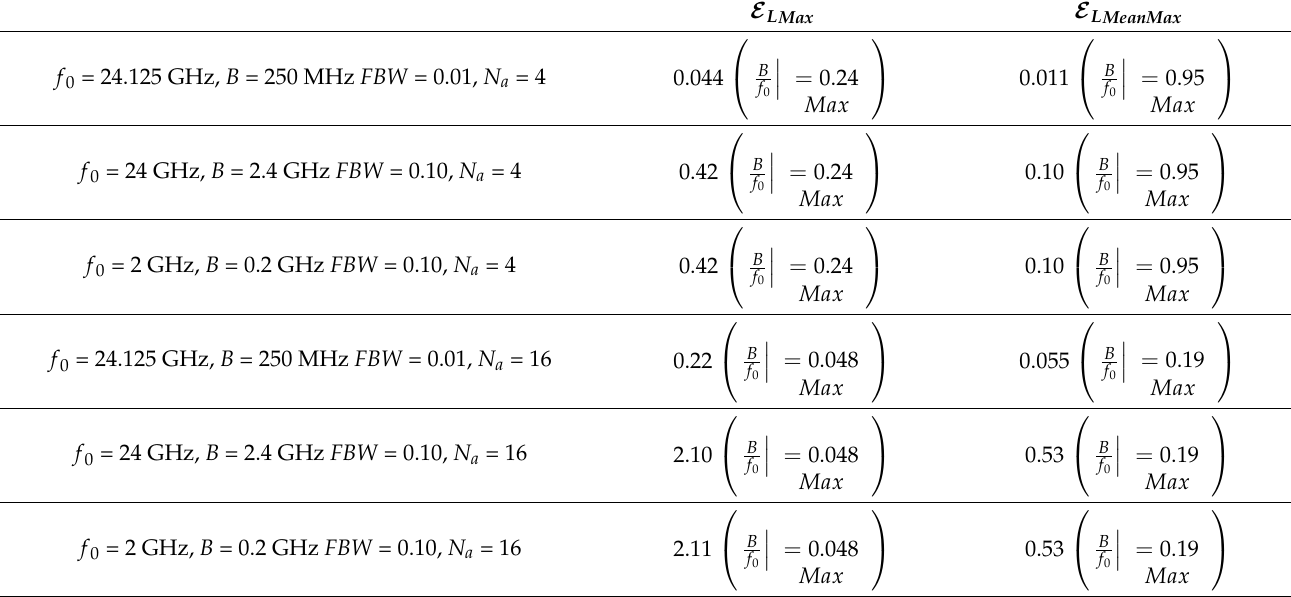
Table 2. Phase error produced by the approximation of the linear term. E LMax E